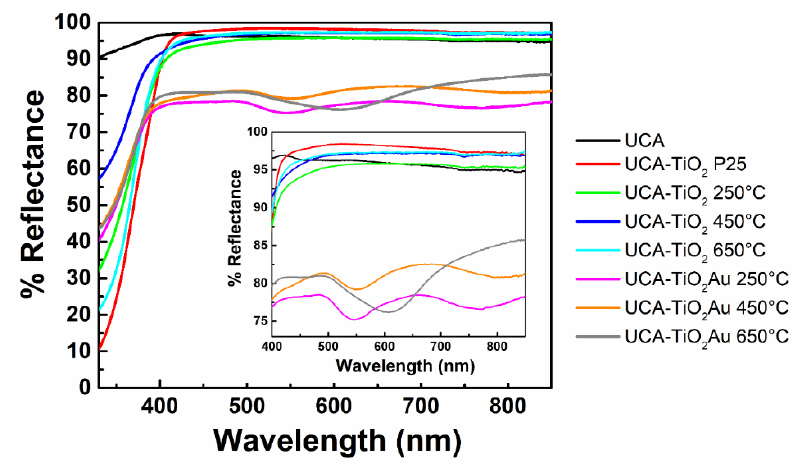
Figure 3. Diffuse reflectance spectra UV-Vis of UCA–TiO 2 and UCA–TiO 2 Au nanocomposites powders under study. In the inset is reported the detail of visible range.